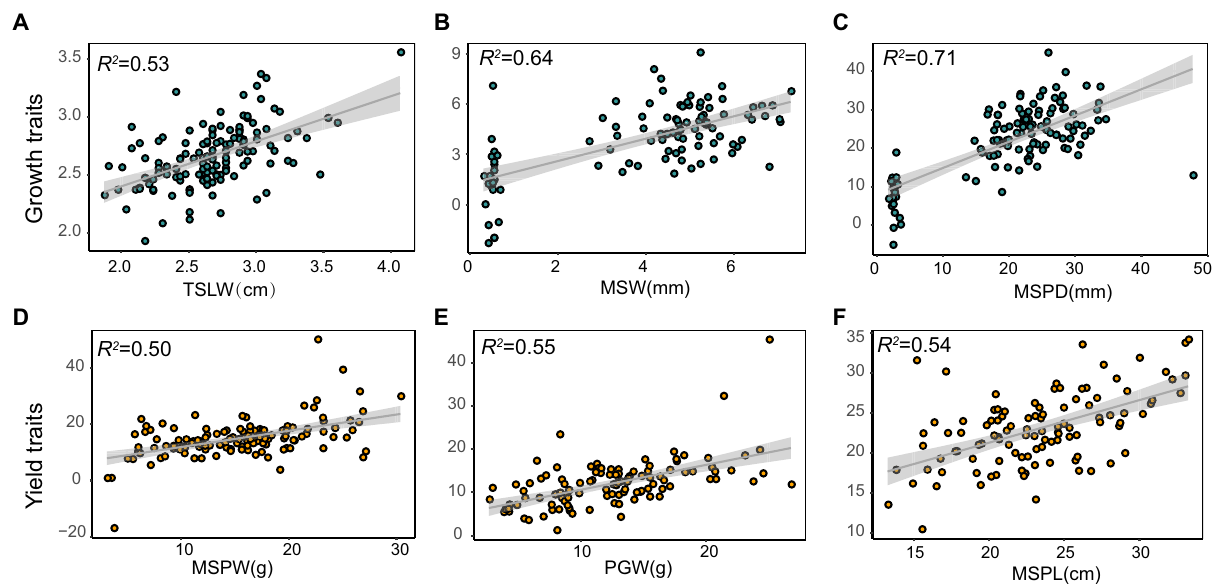
010203040 Fig. 2 | Combined effects of genetic variations and root-associated microbiota on 136, 100, 117, 126, 110 and 106 samples in the testing dataset, respectively. The on agronomic traits of foxtail millet. A – F The variation of growth (TSLW, MSW, dark trend line illustrates the predicted effect in the linear model (LM). The gray MSPD) and yield (MSPW, PGW, MSPL) traits explained by the genetic SNPs and shadingaroundthelinerepresentsacon fi denceintervalof0.95.TSLW,topsecond microbial OTUs combined. Each panel shows observed values on the x-axis and leaf width; MSW, main stem width; MSPD, panicle diameter of the main stem; model-predictedvaluesontheyaxis,witha fi ttedlinearregression.Speci fi cally,the MSPW, main stem panicle weight; PGW, per plant grain weight; MSPL, panicle predicted value of TSLW, MSW, MSPD, MSPW, PGW, and MSPL iscalculated based length of the main